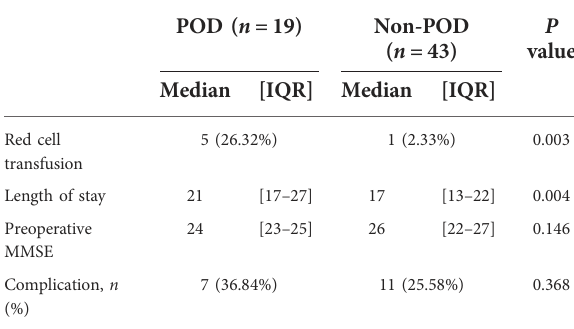
TABLE 1 Comparison between patients with and without